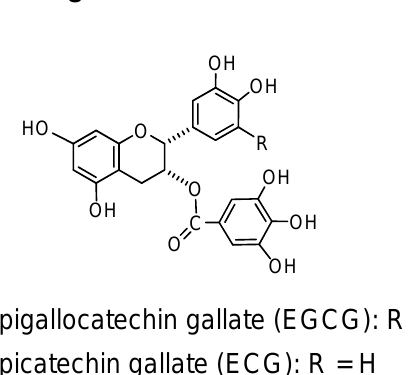
Figure 9. Green tea